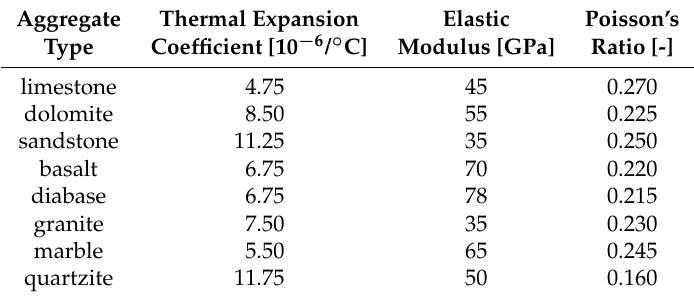
Table 2. Thermal expansion coefficients [1] and elastic parameters [39] of commonly-used concrete